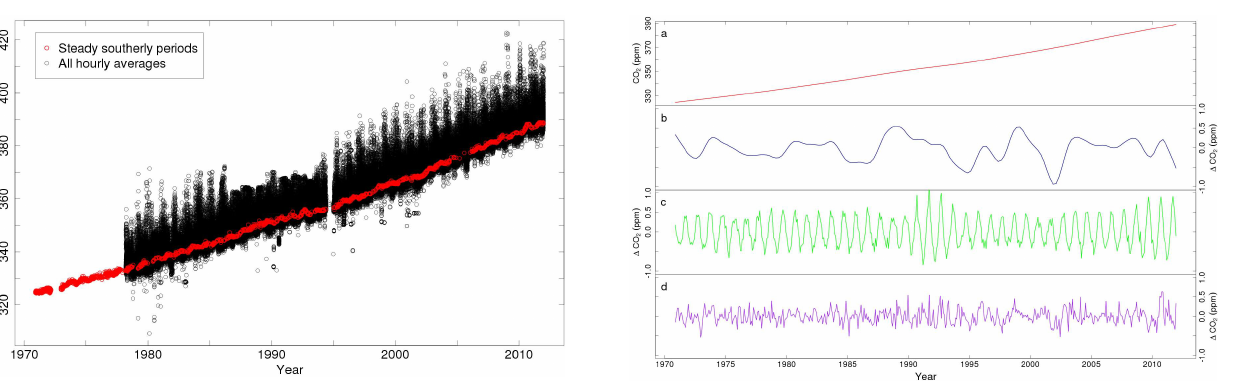
Fig. 4. Results of STL decomposition of the Baring Head steady pe- riod CO 2 record. (a) trend component found using 10-year window, (b) interannual component found using 2-year window, (c) seasonal component using a 5-year window on monthly trends, and (d) re- mainder component. For (b–d) , the y-axis scales are similar. The fits include data prior to December 1972 from the Makara